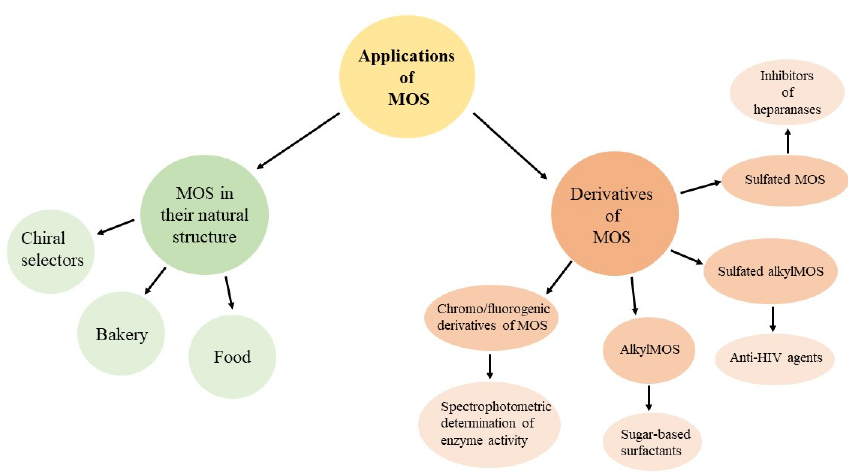
Figure 2. Applications of